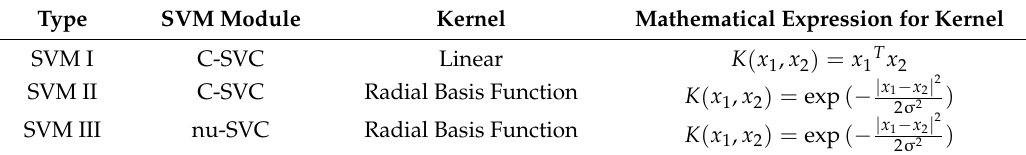
Table 1. Three types of support vector machine (SVM) and corresponding kernel functions used for